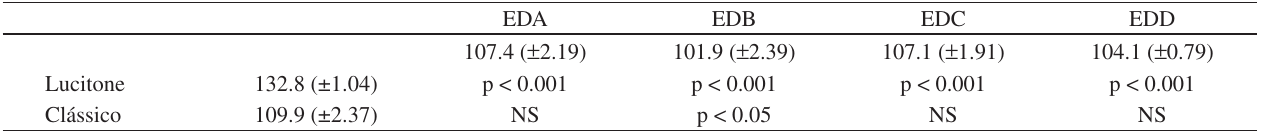
Table 4. Fracture resistance (MPa). Comparison of materials available in the dental market and injected experimental materials.